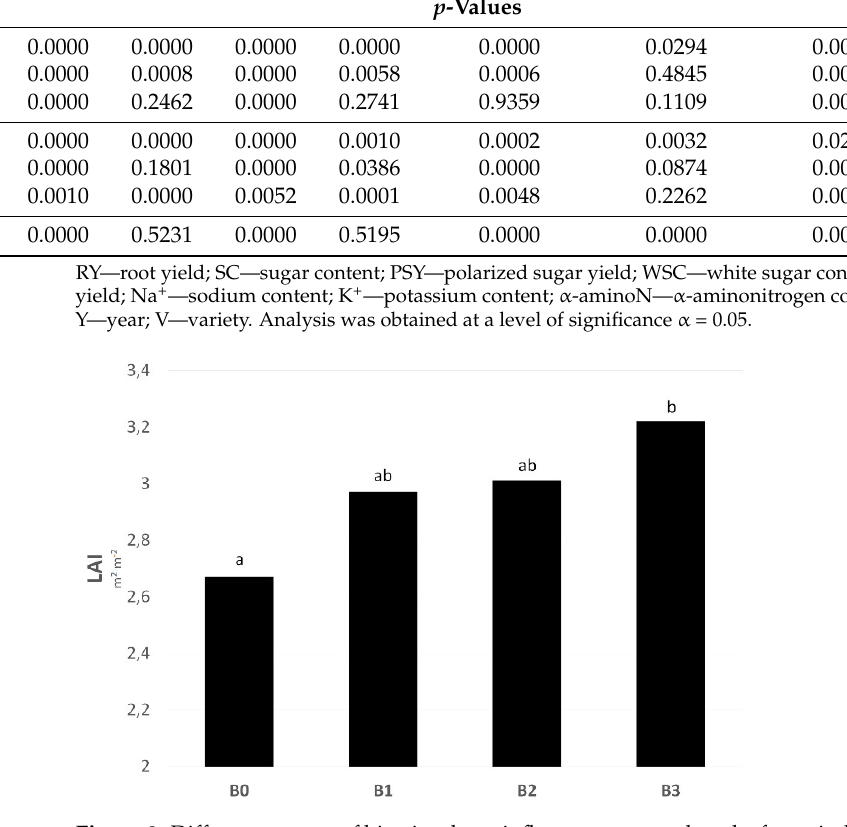
Figure 2. Different sources of biostimulants influence on sugar beet leaf area index (LAI). B0—con-